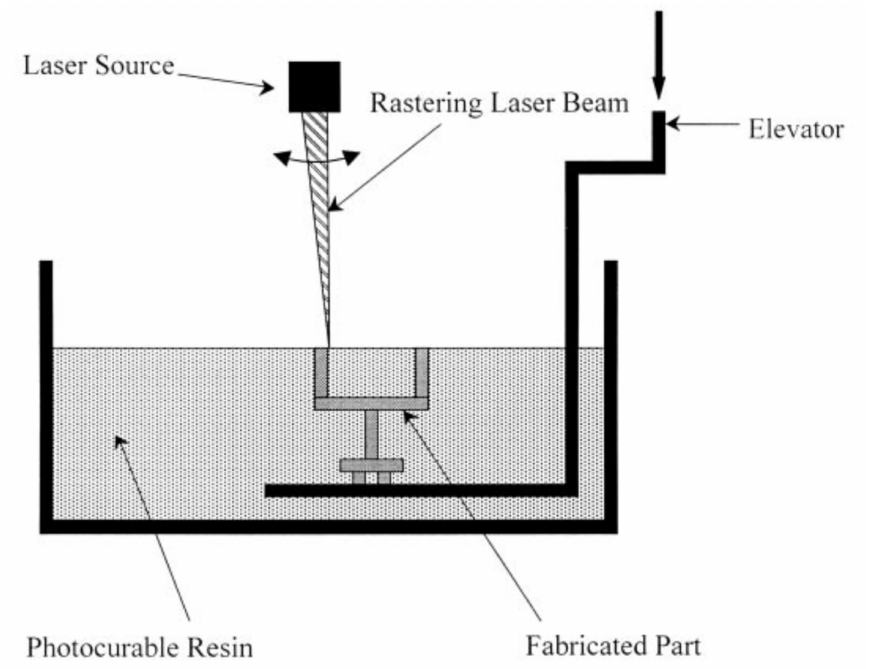
Figure 7. Schematic of the vat polymerization process [35]; with permission from